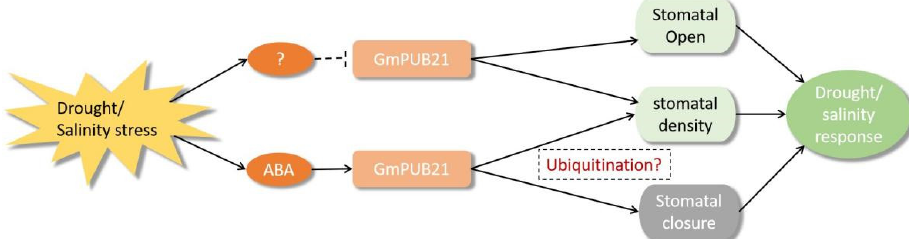
Figure 8. Modes of action of the GmPUB21 U-box E3 ligase was divided into two different pathways: ABA-dependent and other signals. GmPUB21 as a positive effect on the ABA signaling pathway promote the stomatal closure. The other signal by which GmPUB21 regulates drought and salinity responses is not known. Overexpressing GmPUB21 leads to increasing the stomatal density, and also regulated the stomatal aperture in response to drought and salinity stress. In addition, GmPUB21 as a U-box E3 ligase may involved in the ubiquitination pathway to regulate the devel- opment of stomata and the response to drought and salt stress.